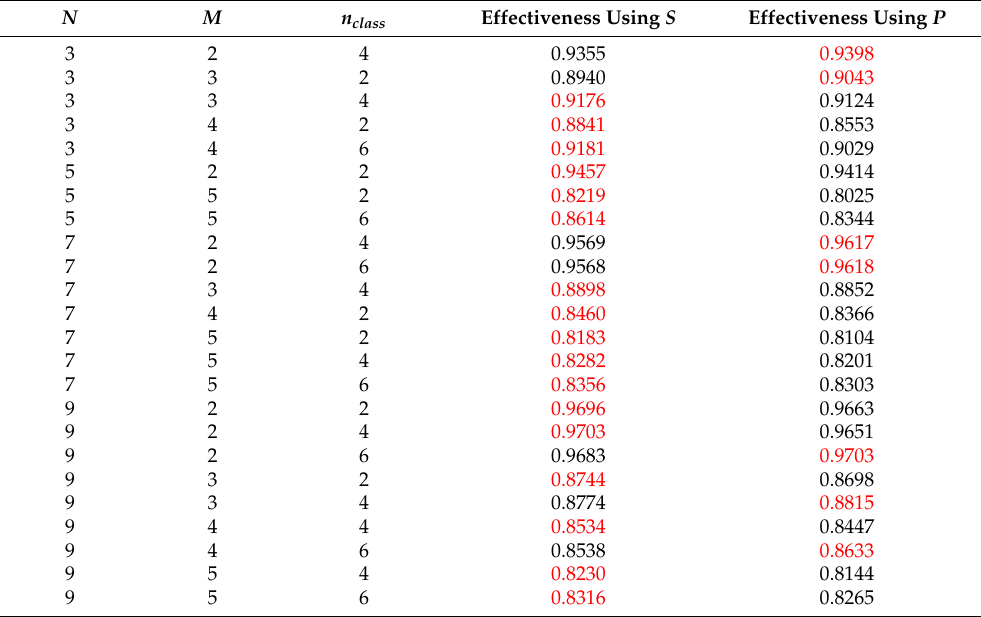
Table 5. Comparison between the effectiveness of the method based on representative profiles using the reflexive relation S and using the asymmetric relation P